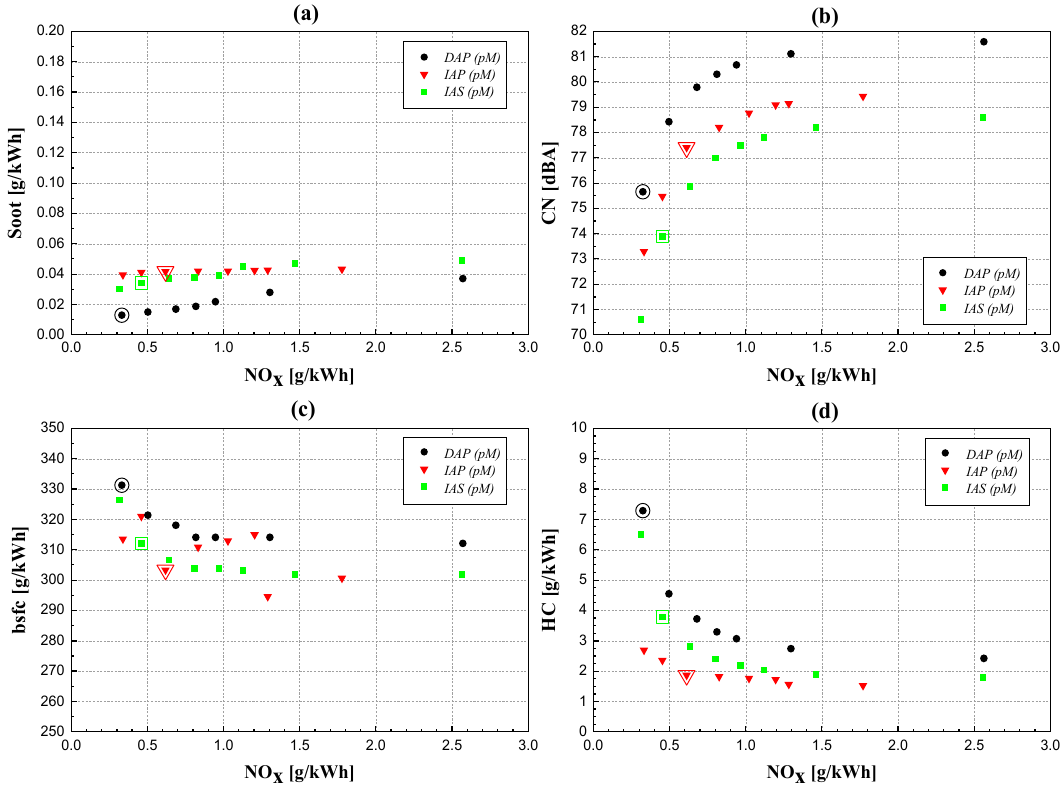
Figure 5. Engine-out soot emissions ( a ) CN; ( b ), bsfc ; ( c ) and engine-out HC emissions; ( d ) vs. NO x for the three injector typologies, at 1500 × 2.